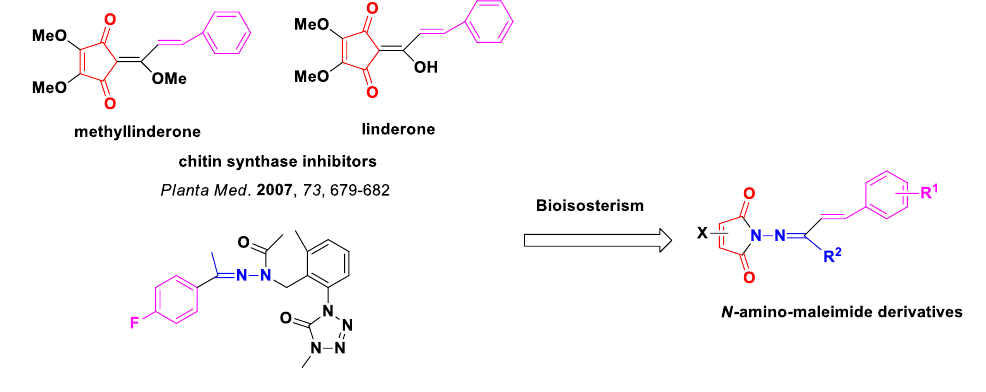
Figure 3. Design strategy for N -amino-maleimide derivatives.